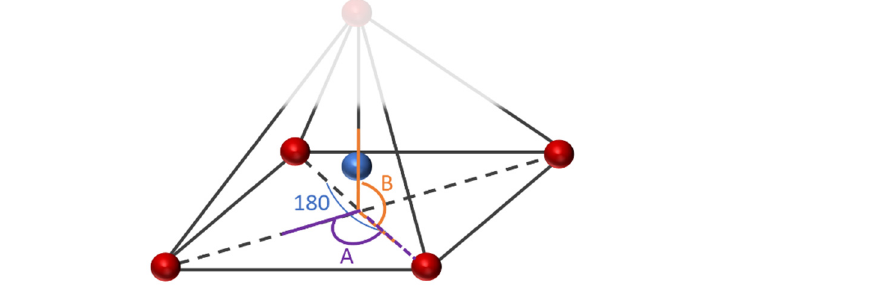
Figure 5. The studied side angles and (180) angle for the 2n Fe-PESA complexes in Table 1.